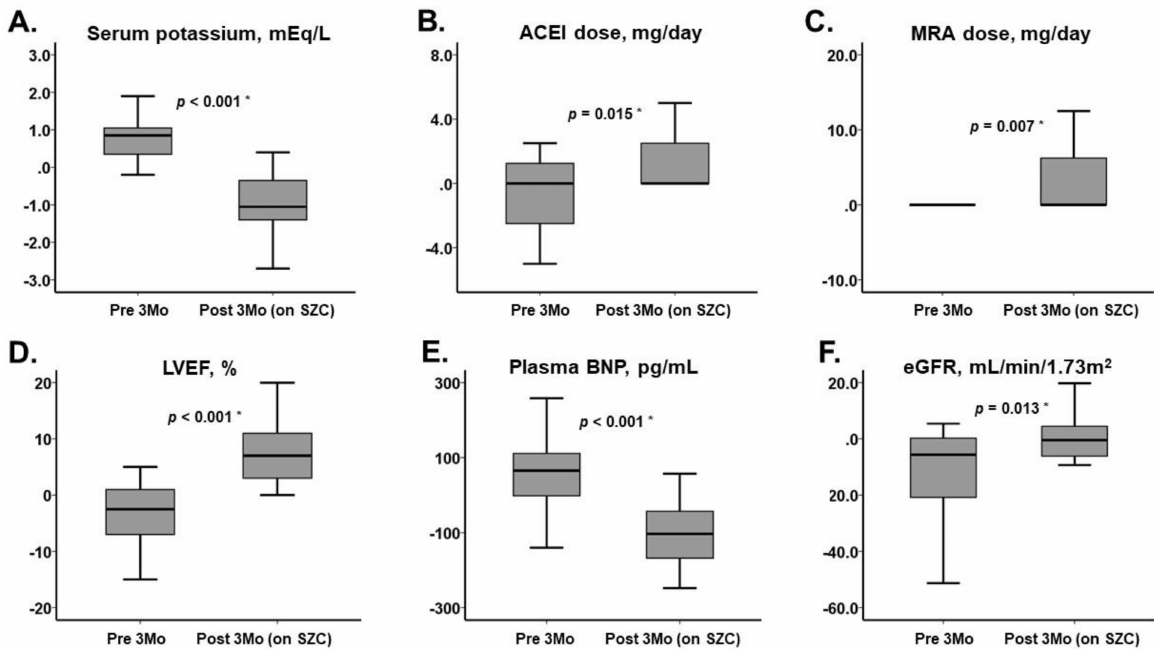
Figure 2. Changes in major clinical parameters during pretreatment period and treatment period on SZC. ( A ) Serum potassium, ( B ) ACEI dose, ( C ) MRA dose, ( D ) LVEF, ( E ) Plasma BNP, ( F ) eGFR. Abbreviations as in Figure 1. * p < 0.05 by Mann-Whitney U